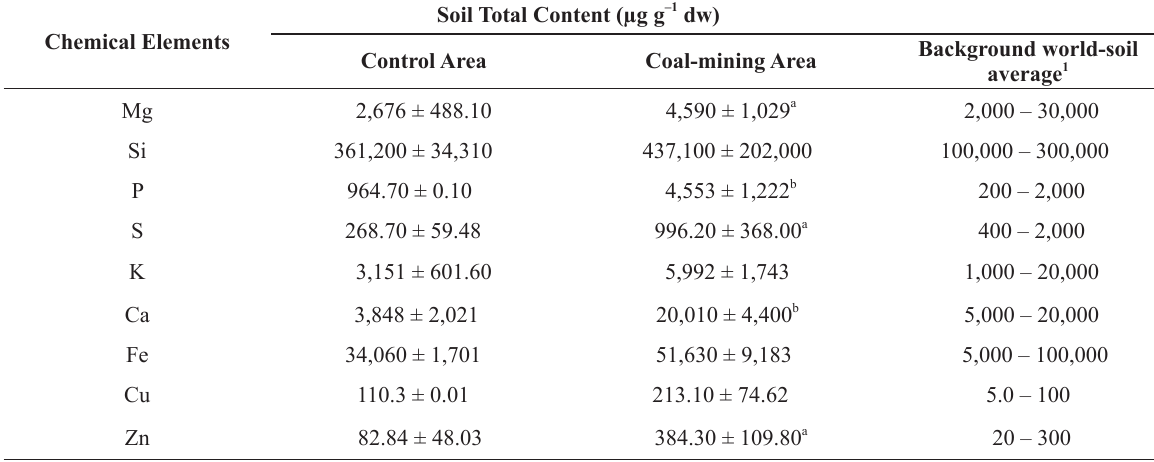
Elemental composition (µg g –1 dw) of soil from control and coal-mining areas determined by PIXE analysis. Chemical